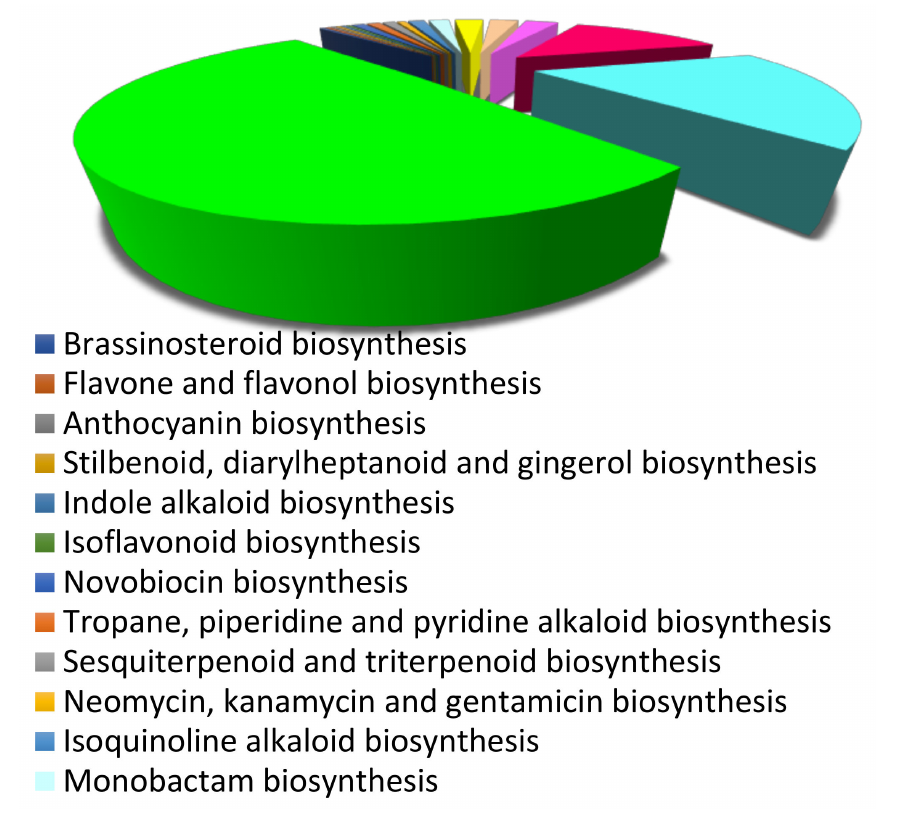
Figure 2. KEGG pathway analysis based on secondary metabolite biosynthesis in root transcriptome of Sida